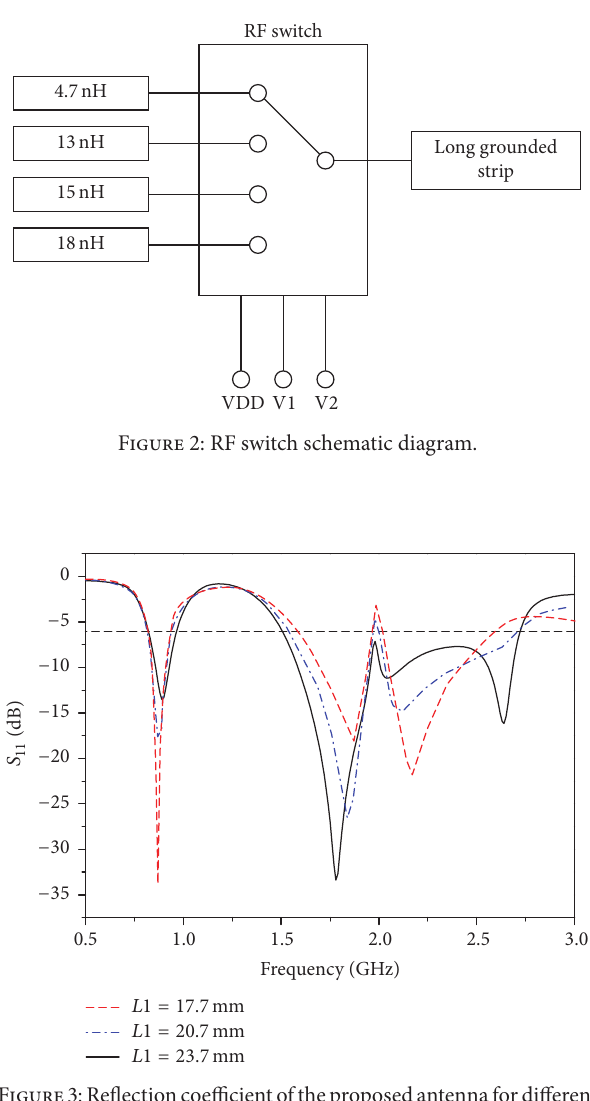
Figure3:Reflectioncoefficientoftheproposedantennafordifferent value of L